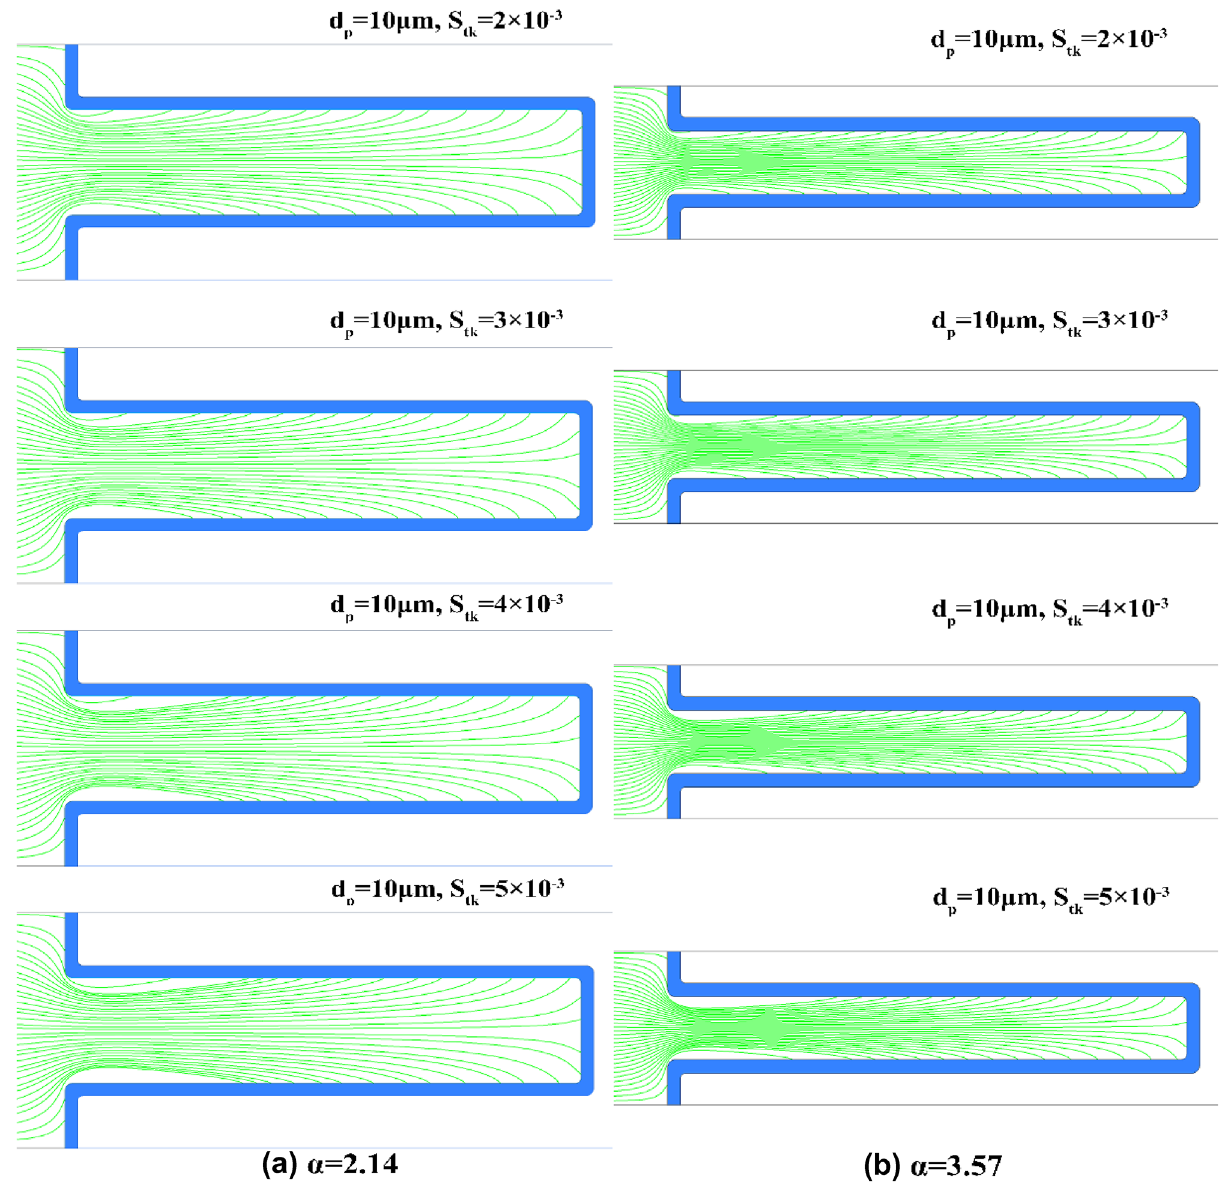
Figure 16. Motion trajectories of particles at different S tk